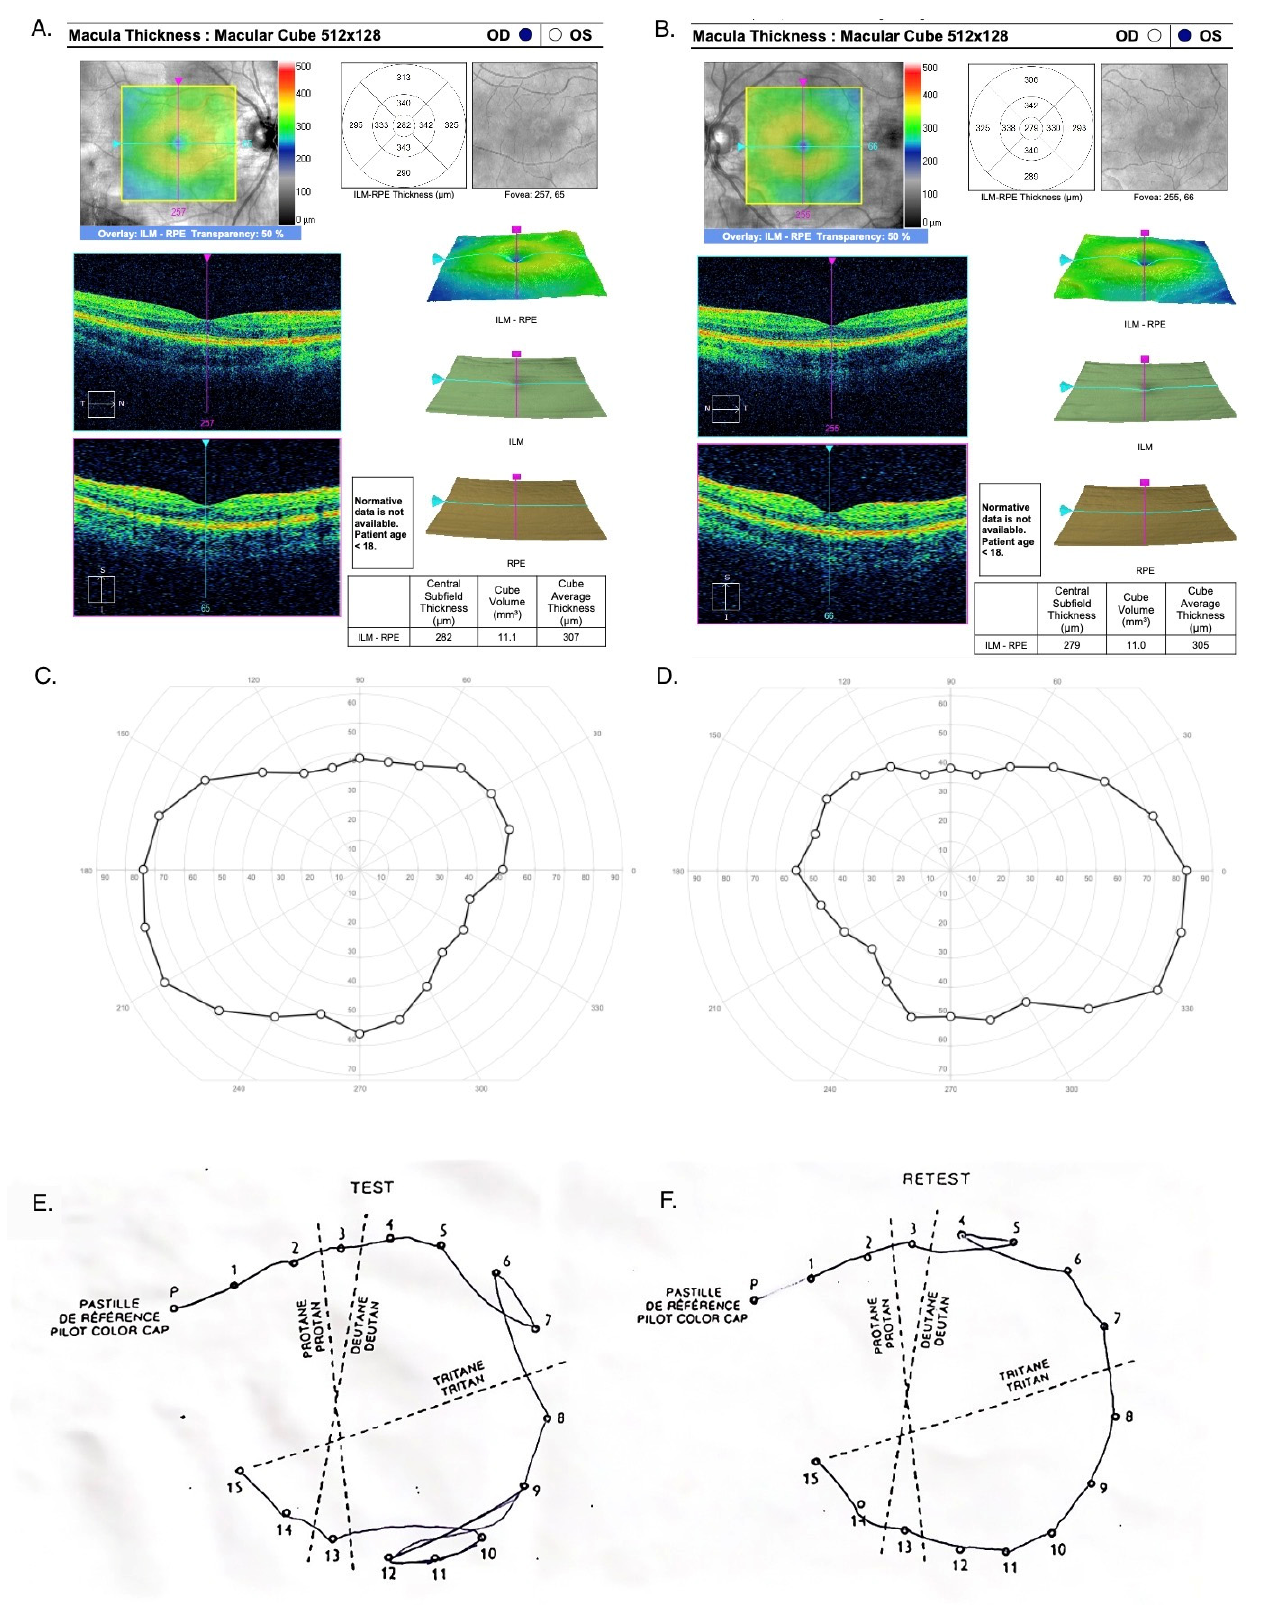
Figure 2. Correct recording in the OCT, RE ( A ) and LE ( B ); kinetic perimetry, RE ( C ) and LE ( D ); and Farnsworth D-15 tests, RE ( E ) and LE ( F